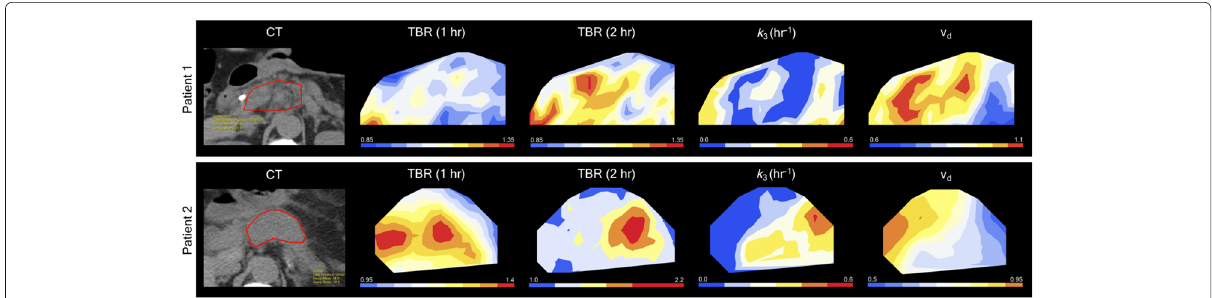
Fig. 3 Examples of negative correlations between k 3 and v d and discordance between k 3 and TBR in parametric maps for patients 1 and 2. From left to right: pre-PET transverse CT scan; FAZA-PET TBR at 1 h for the tumour contour shown on the CT; TBR at 2 h; k 3 map; v d map. Strong negative correlations between k 3 and v d are evident. In both tumour slices, there are regions where v d is well-below unity and variations in k 3 and TBR are